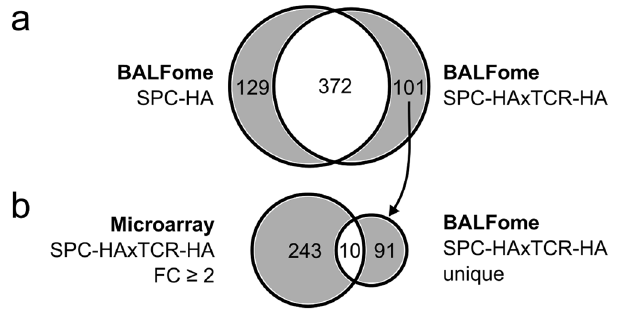
Figure 2. Chronic lung inflammation alters the BALF proteome. ( a ) Venn diagram comparing LC-MS/MS- identified proteins from bronchoalveolar lavage fluid (BALF) of SPC-HA vs. SPC-HAxTCR-HA mice. Samples were pooled from 5 mice/group. ( b ) Venn diagram comparing genes with ANOVA p-value p < 0.05 and a fold change FC > ± 2 in lungs of SPC-HAxTCR-HA mice vs. genes (identified by their respective products) only detected in BALF from SPC-HAxTCR-HA